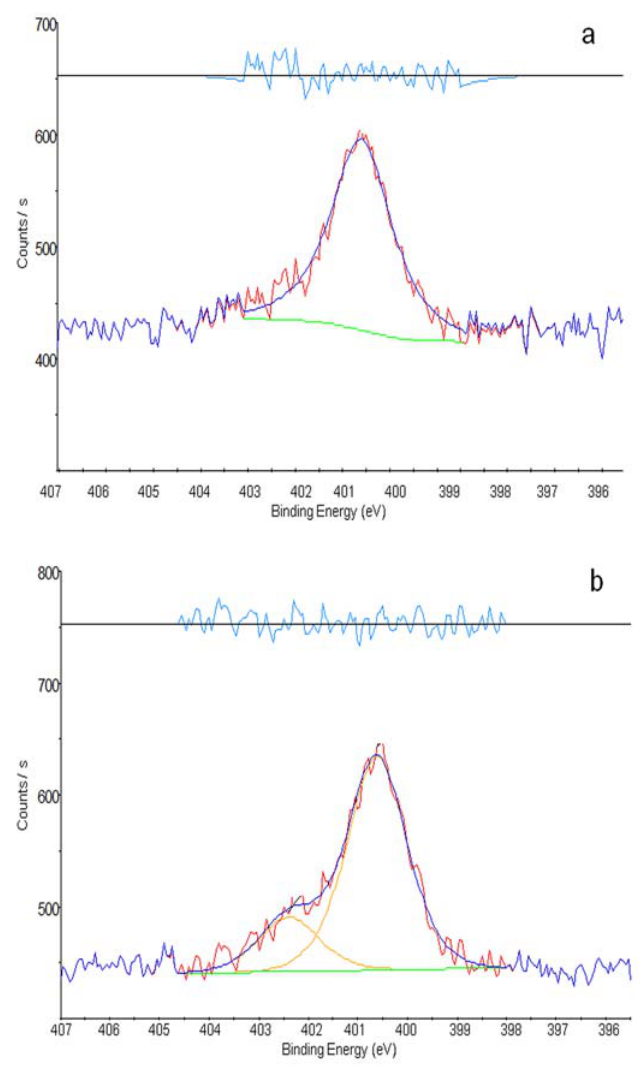
Figure 6. Comparison of fit of the S2p regions: ( a ) 8-hydroxyquinoline-5-sulphonic acid/glassy carbon electrode (HQSA/GCE) and ( b ) HQSA powder. The plots of residuals above the fitted peaks shows the (properly expanded) differences between experimental and synthesized spectra